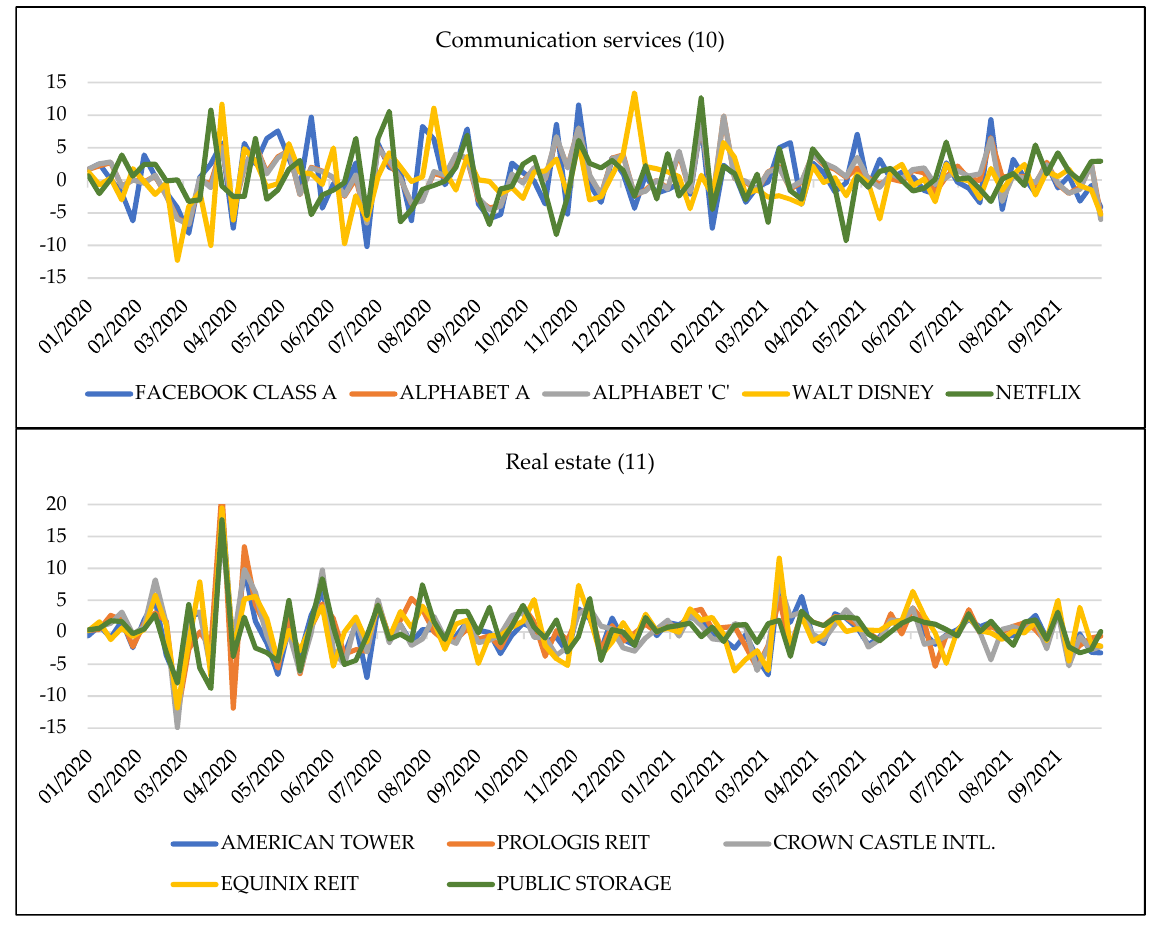
Figure A1. Average weekly rates of return of top five companies from alternative energy and main stock market sectors in January 2020–September 2021. Source: Authors’ own calculations and elaborations based on Refinitiv Datastream. Table A2. Descriptive statistics for average weekly rates of return and daily prices: based on top five companies from stock market sectors. January 2020–September